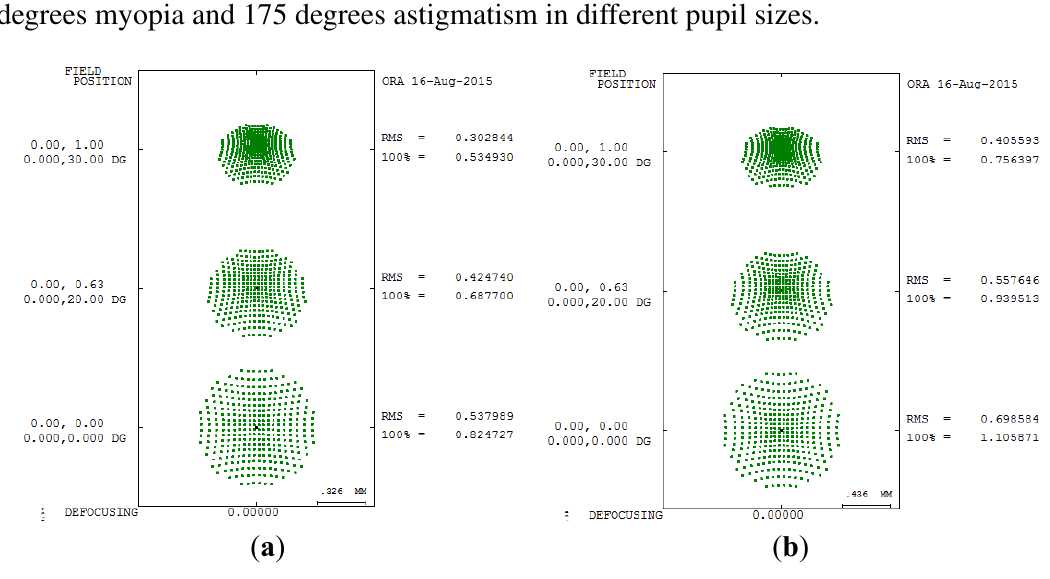
Figure 5. Spot size diagram of 550 degrees myopia and 175 degrees astigmatism. ( a ) 5 mm; ( b ) 6 ( b ) 6 mm.